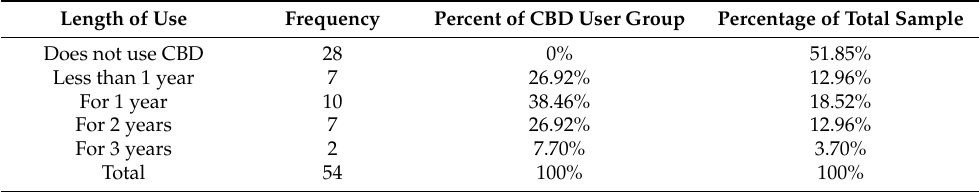
Table 2. The length of CBD use reported by the